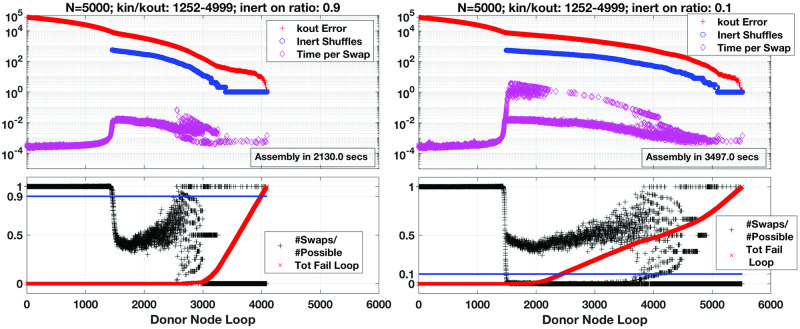
Progression of method reducing error, rout, for sample network sized N = 5000; note, degree sequence generated according to a uniform distribution and positive correlation (ρ = 0.5) between in- and out-bound degree.This particular sequence further selected for relatively high-density and range of connectivity, with maximal degrees at or near N − 1. Error rout shown over each donor loop, time elapsed per individual edge swap, and number of inert shuffles per loop (upper panes). Note, inert shuffling activated according to two different thresholds: a high activation threshold (left) and low (right), depending on ratio of (# edge swaps / # possible swaps) (black trace, lower panes). Blue traces in lower panes show thresholds of inert shuffling activation for comparison (0.9 and 0.1, respectively). At a high activation ratio of 90%, inert shuffling triggers at donor loop #1457, in this instance, postponing failed loops, defined as donor loops with no edge transfers (normalised total failures over all loops, red trace, lower panes). Compare with the activation ratio set to 10% where inert shuffling enters at donor loop #1495. Although this delay in inert shuffling appears slight, the influence on number of failed loops and also time to perform edge swaps (upper panes) is dramatic, further reducing overall time of assembly by about 40%.